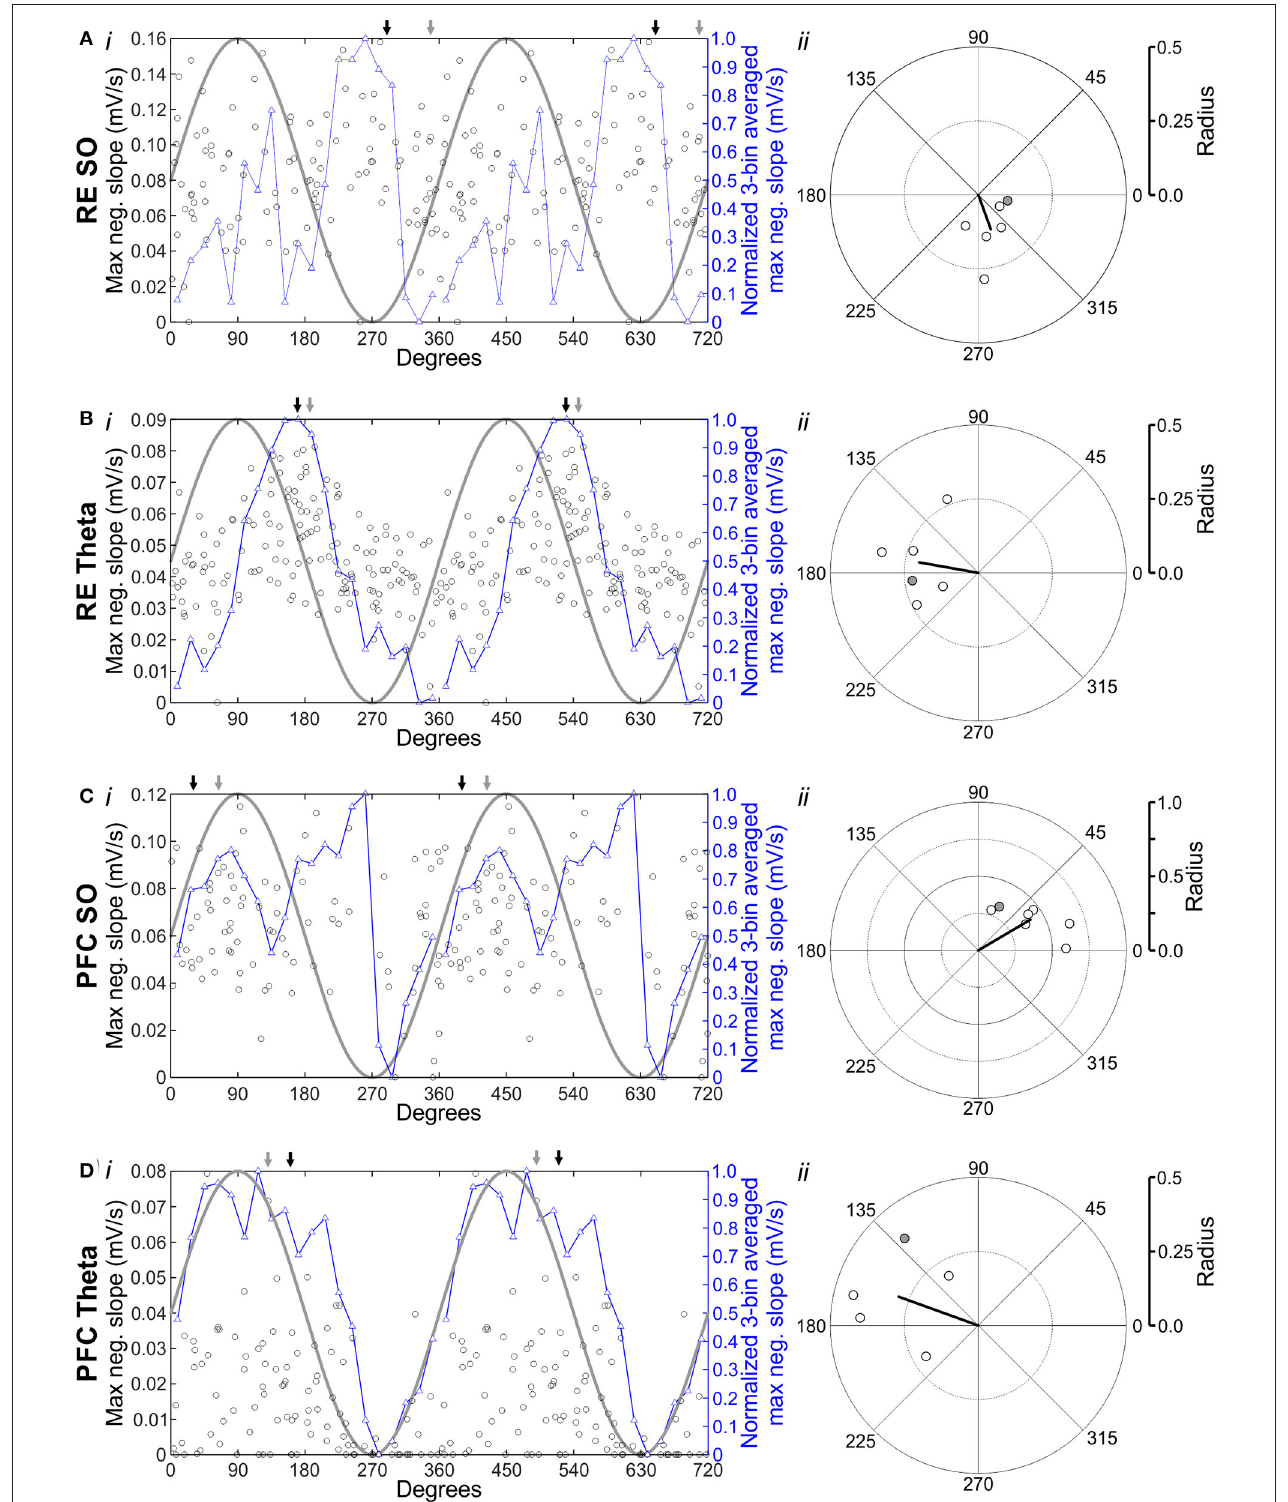
FIGURE 8 | Hippocampal excitation is modulated by the phase of the ongoing forebrain rhythm. (Ai) Stimulating RE during SO evokes an HPC response with a variable maximum slope. Each black hollow circle represents the maximum negative slope evoked by stimulation of RE, which fluctuates as a function of the phase in the oscillatory cycle that the pulse was delivered at. Phase values were organized into 20 equivalent 18 ◦ bins, and the average maximum slope for each bin was